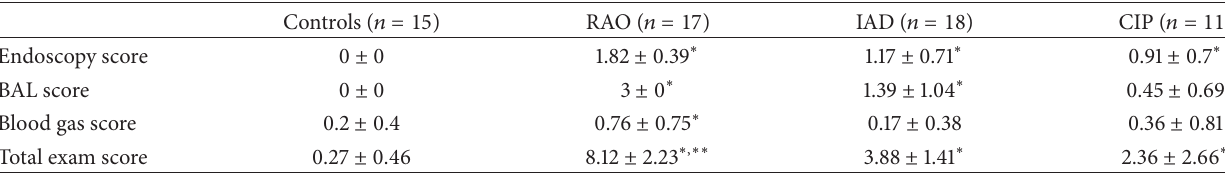
Table 2: Results of clinical examinations. ∗ shows significant increase to controls at 𝑝 < 0.05 and ∗∗ significant increase in RAO compared to IAD and CIP. RAO: recurrent airway obstruction, IAD: inflammatory airway disease, and CIP: chronic interstitial pneumopathy.